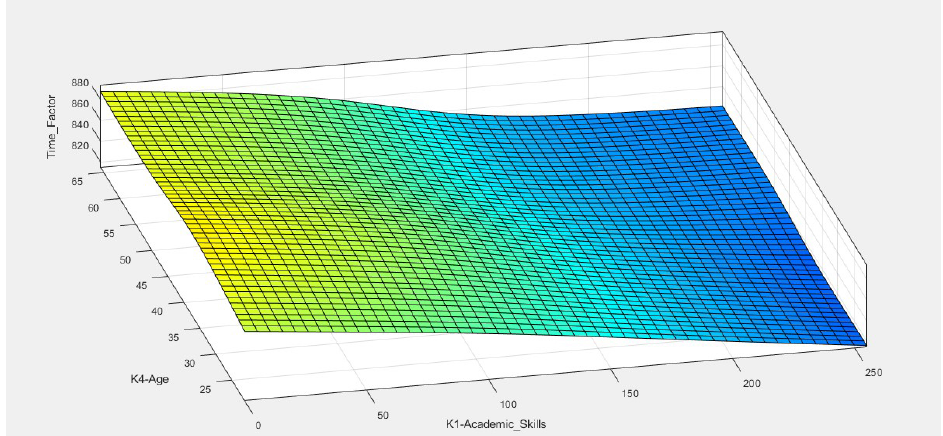
Figure 8. Results of academic skills and age